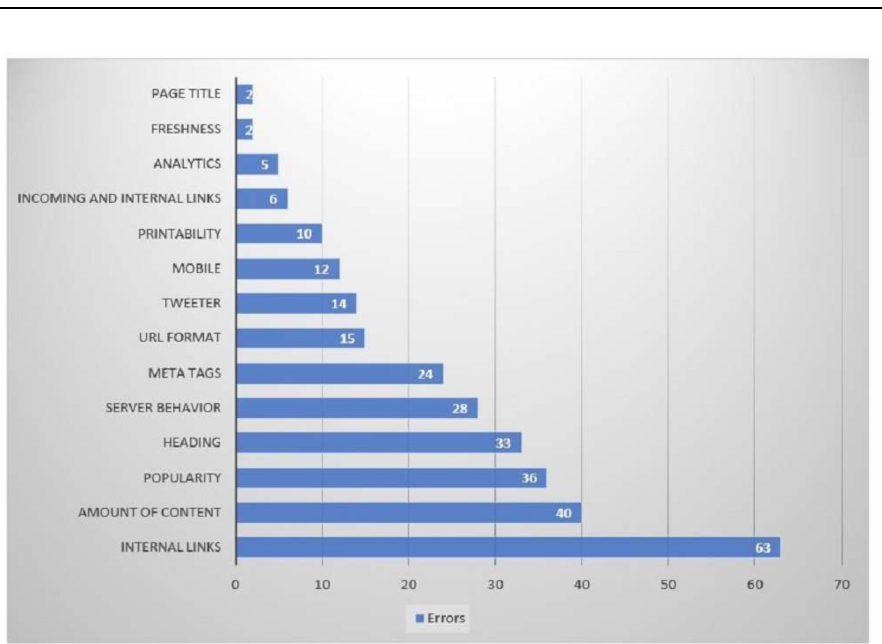
Figure 10. Frequently appeared violations identified by